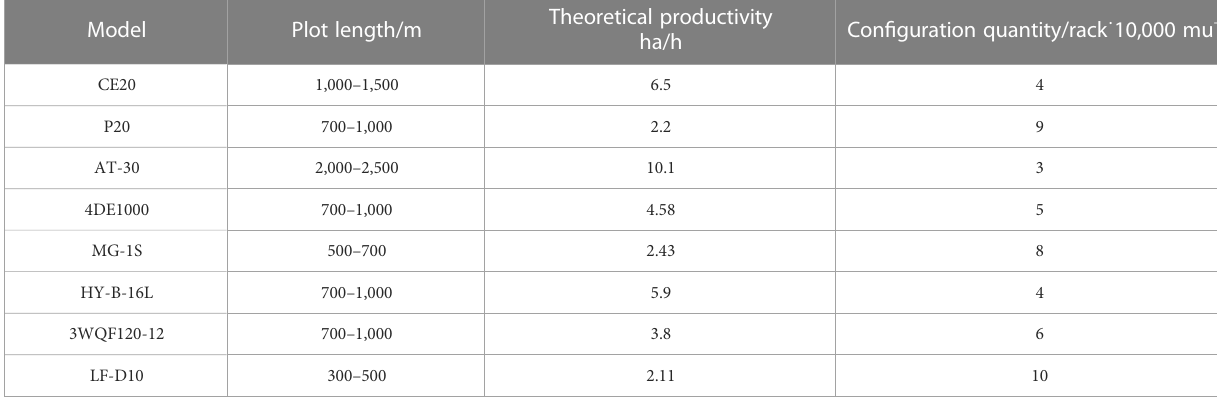
TABLE 4 Suitable plot lengths and the number of con fi gurations for each model.